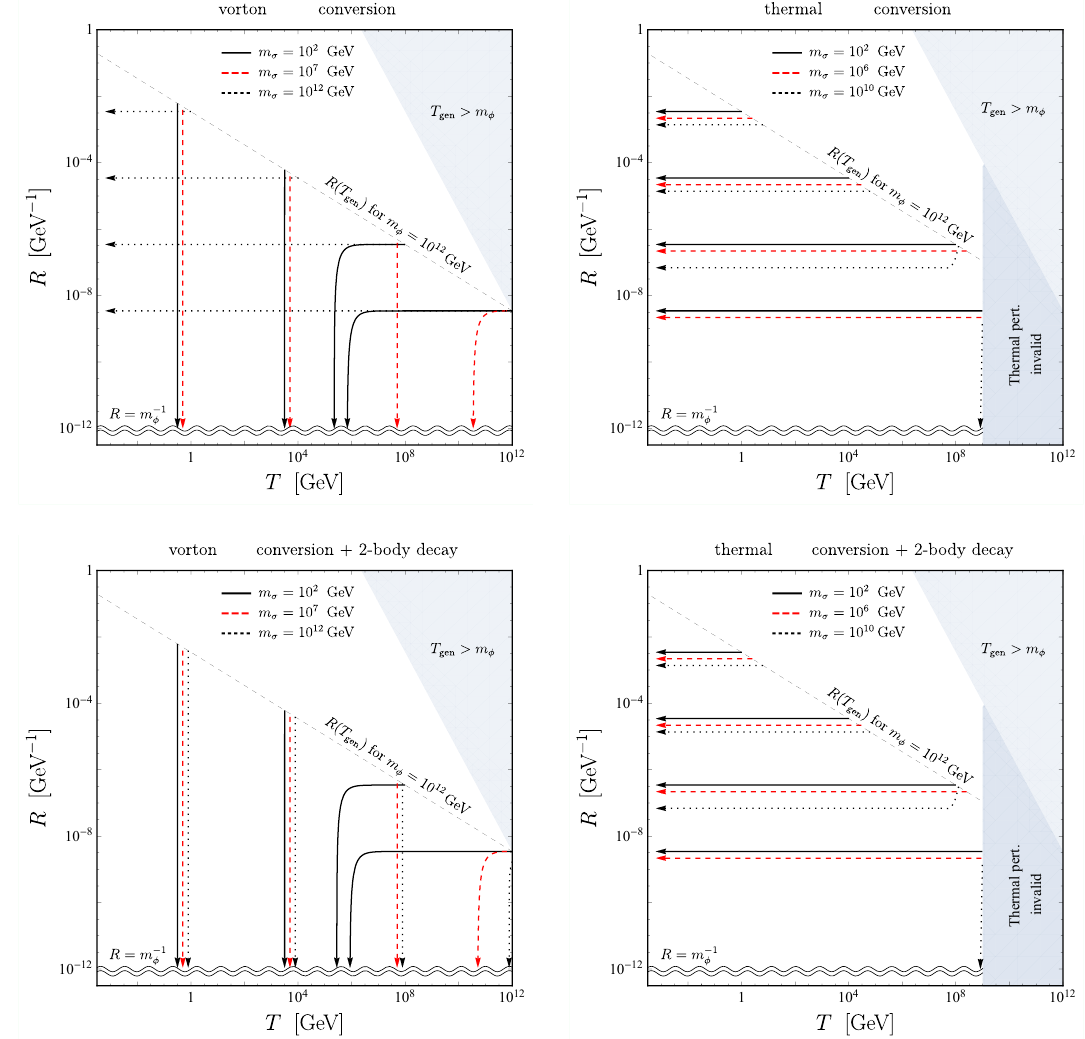
Figure 10 . The time evolution of the vorton radius R with various production temperatures and E = m φ = 10 12 GeV . The lines with arrows indicates the trajectories of the vorton radii for different m σ and T gen . These figures differ with respect to the type of string curves and decay processes as indicated. In the gray regions, the temperature T does not satisfy the condition eq. (4.10) and we assume no decay process occurs in the